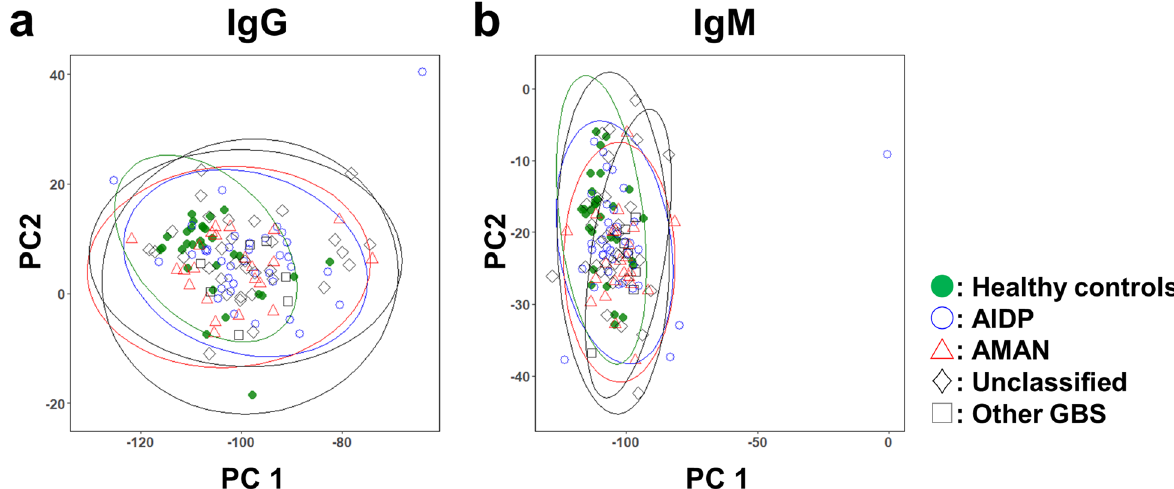
Figure 3. Principal component analysis (PCA) of anti-glycolipid IgG and IgM antibody data from 100 GBS samples, which were composed of 37 acute inflammatory demyelinating polyneuropathy (AIDP), 23 acute motor axonal neuropathy (AMAN), 33 “Unclassified”, and seven “Other GBS” samples, and 30 healthy control (HC) samples. ( a ) PCA of IgG glycoarray data did not separate distinct populations among the GBS subgroup and HC samples by principal component (PC) 1 or PC2 values. An ellipse of the 99% confidence interval drawn for each GBS subgroup or HC group showed the presence of outliers did not explain the failure of the separation as a distinct population by PCA. ( b ) PCA of IgM glycoarray data also did not separate